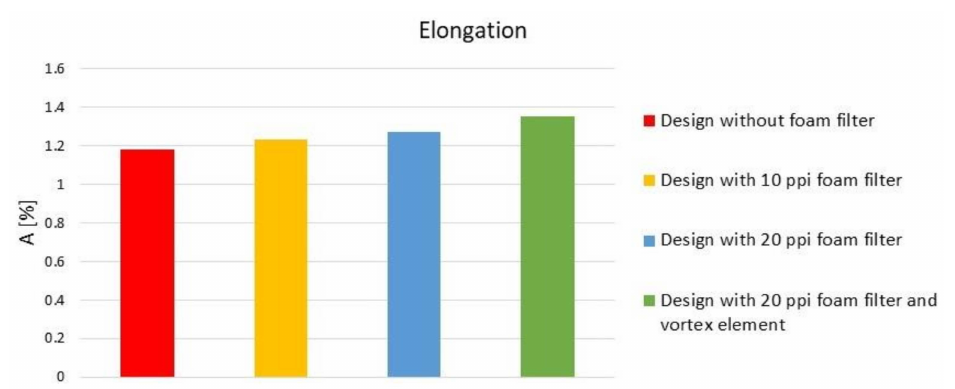
Figure 10. Results of elongation evaluation.